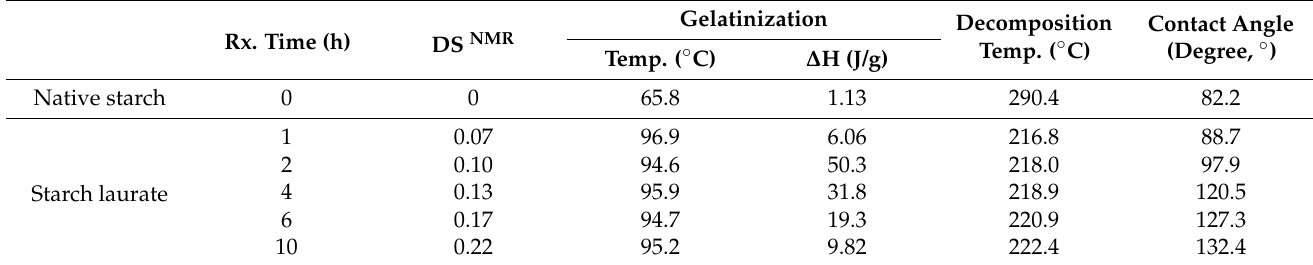
Table 2. Thermal properties of cassava starch and starch laurates.